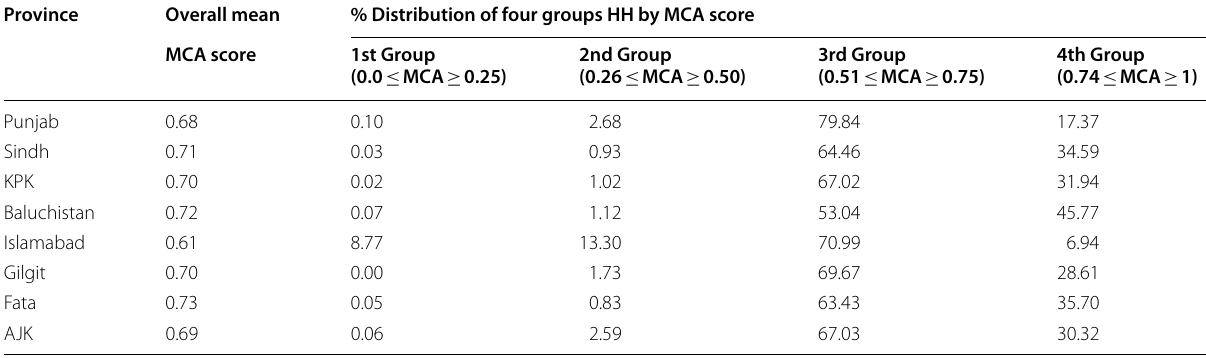
Table 4 Provincial asset-based poverty by decomposition of MCA score. Source : Author’s own calculation